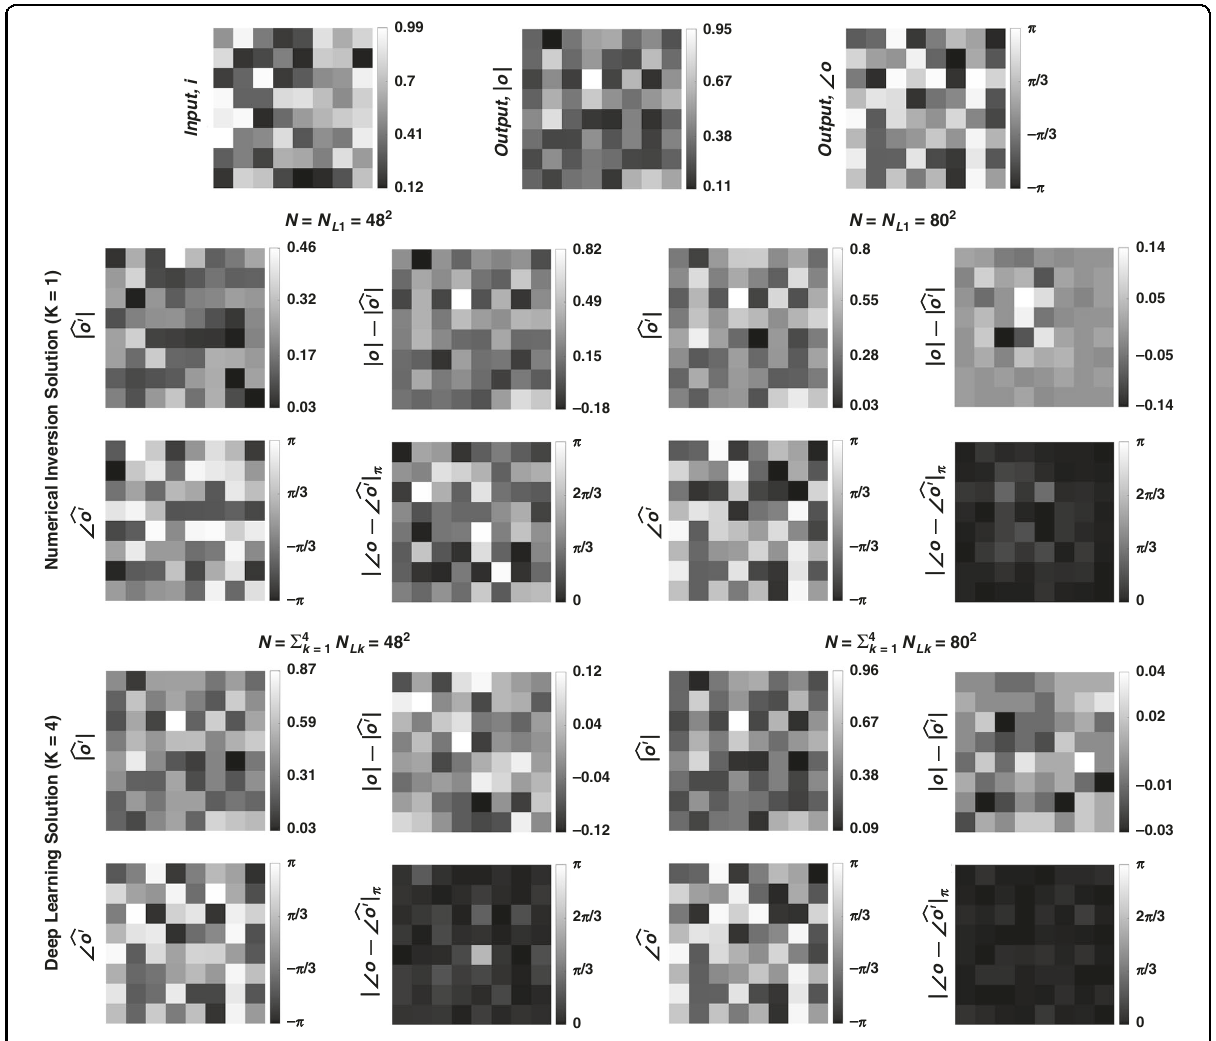
Fig. 6 Sample input – output images for the ground truth transformation presented in Fig. 4b and the optical outputs by the diffractive designs with N = 48 2 and N = 80 2 . The magnitude and phase of the normalized output fi elds and the differences of these quantities with respect (cid:5) (cid:5) (cid:5) (cid:5) to the ground truth are shown. ff o (cid:2) ff b o ′ π indicates wrapped phase difference between the groundtruth and the normalized output